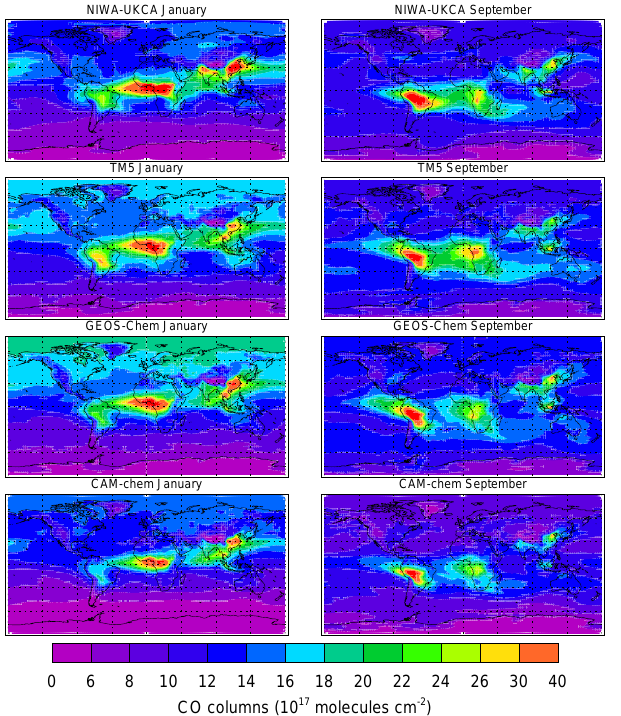
Figure 12. Tropospheric CO 25 tracer columns from four mod- els for January (left) and September (right) 2005, for the CLM- MEGANv2.1